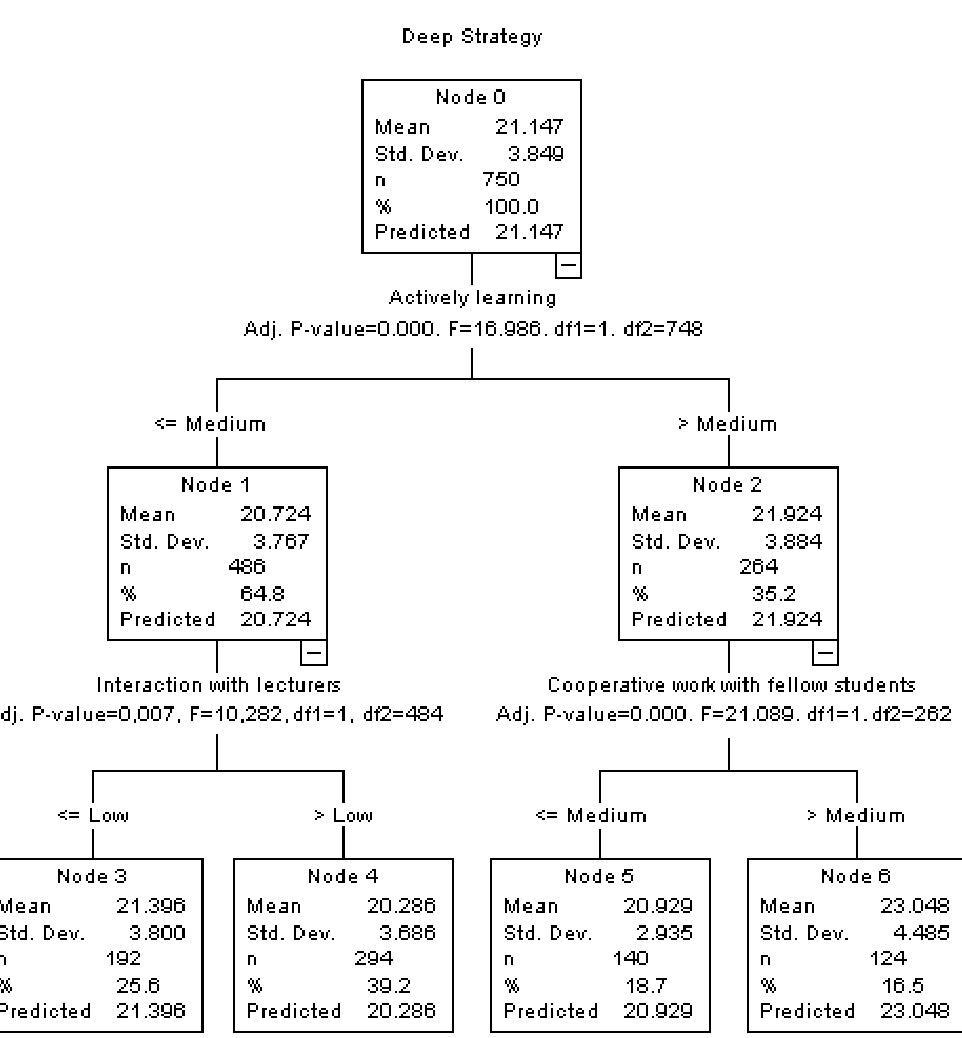
Figure 1. Classification tree for Deep Strategy.